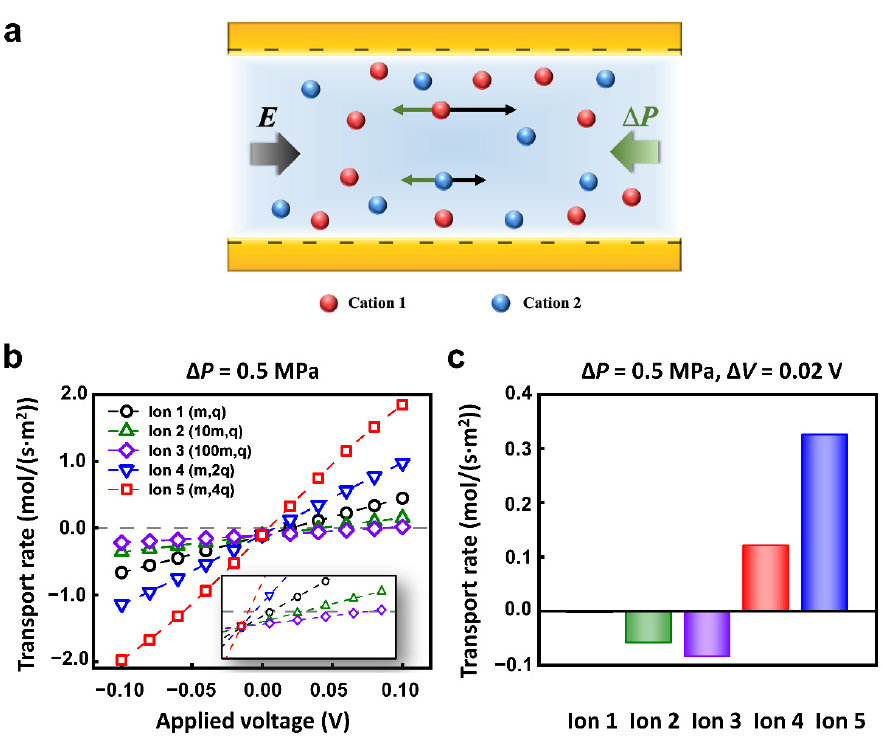
Figure 2. The selective transport of ions under multi-physical fields. ( a ) Schematic of the origin of selectivity. The ions with different charges and masses can achieve distinct motion state. ( b ) The different ions have a special response to the applied physical fields owing to the different masses and charges. ( c ) The selective transport of different ions under appropriate hydraulic pressure and electric potential conditions.